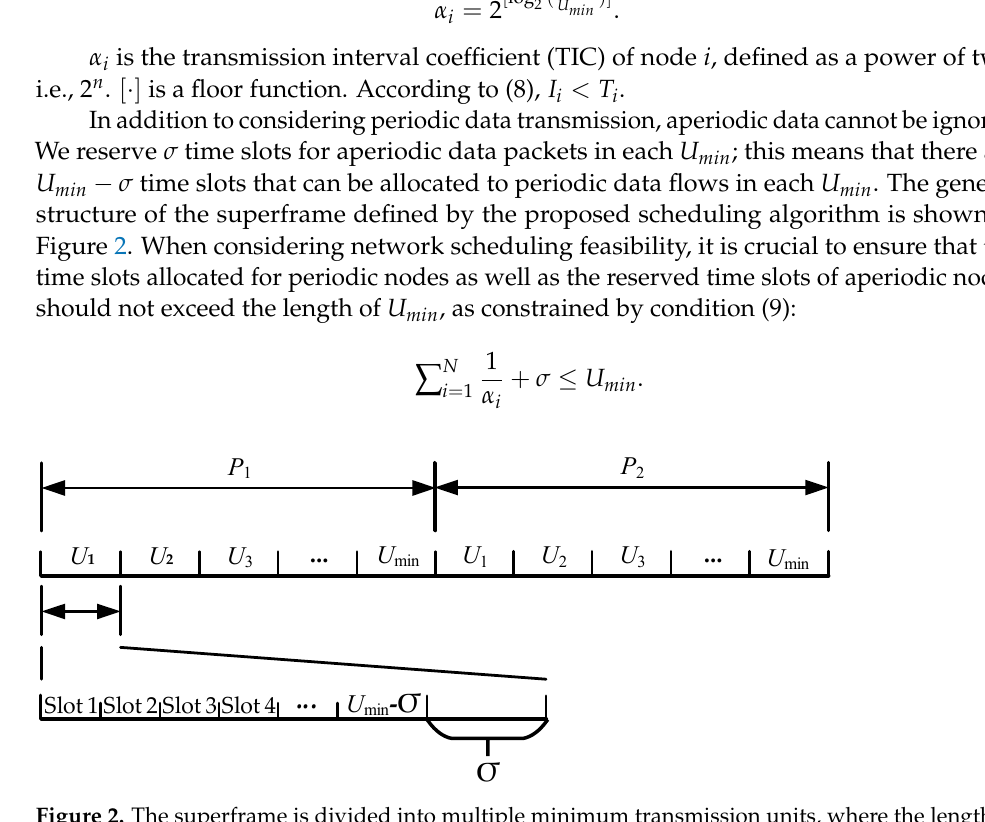
Figure 2. The superframe is divided into multiple minimum transmission units, where the length of each transmission unit is equal to the minimum sampling period in all nodes, and σ time slots are reserved for aperiodic data at the end of each transmission unit.